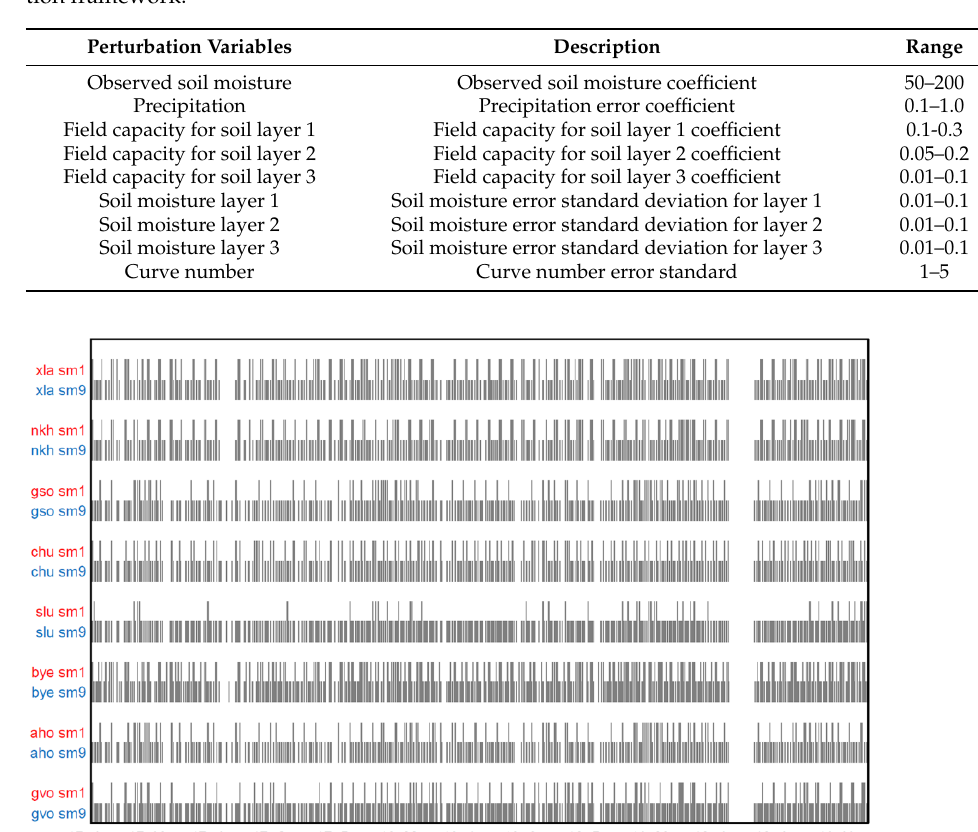
Table A3. Name, description and the range of perturbation defined errors of the EnKF data assimi- lation framework.